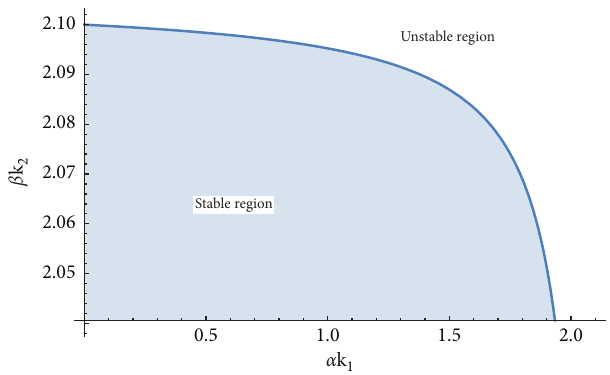
Figure 1: The stable region of the separate bargaining system.